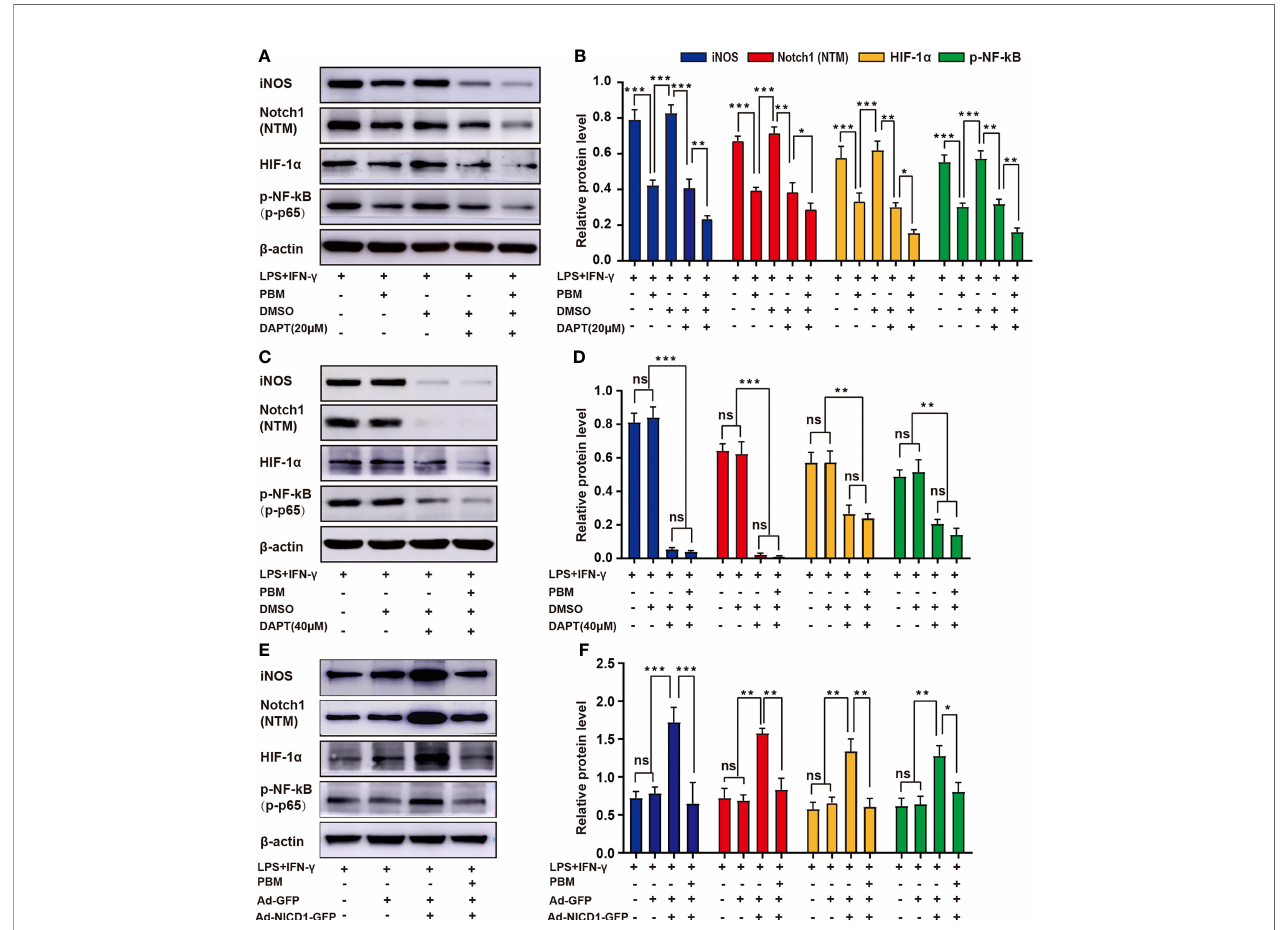
FIGURE 7 | PBM regulates M1 macrophage polarization via the Notch1-HIF-1 a /p-NF- k B axis. (A, B) PBM and DAPT at a concentration of 20 m M synergistically inhibited the neurotoxic polarization of macrophages. Representative blots show the expression levels of iNOS, Notch1 (NTM), HIF-1 a , and p-NF- k B in each group. The expression levels of these proteins were also analysed. (C, D) DAPT alone at a concentration of 40 m M inhibited Notch-related pathways at low levels, masking the effect of PBM on M1 macrophages. (E, F) An adenovirus containing NICD1 was used to activate Notch signalling in macrophages, while the effect of PBM on the protein levels of iNOS, HIF-1 a , and p-NF- k B in Notch-activated macrophages was examined by western blotting (all experiments in this group were independently repeated three times). *P < 0.05, **P < 0.01, ***P < 0.001; ns, not signi fi